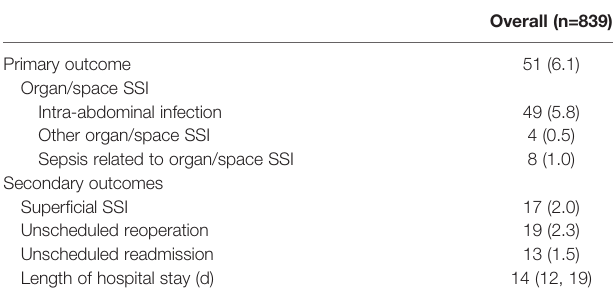
TABLE 2 | Outcome characteristics in advanced digestive system cancer.